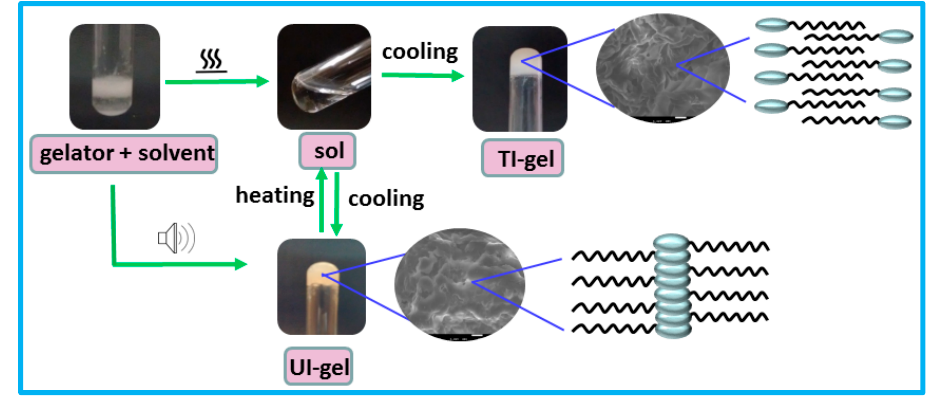
Figure 1. Digital photographs of sol gel transition of ultrasound- and thermally-induced gels.